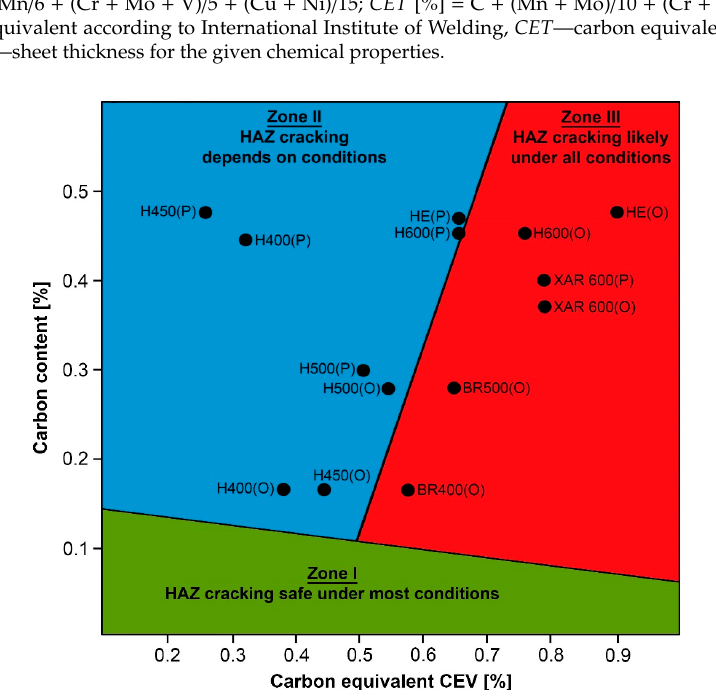
Figure 1. Susceptibility to cracking in function of carbon content and CEV of selected abrasive-wear resistant steels. H—Hardox, BR—Brinar, P—manufacturer’s data, O—own results. Development based on data from Table 3 and [27].